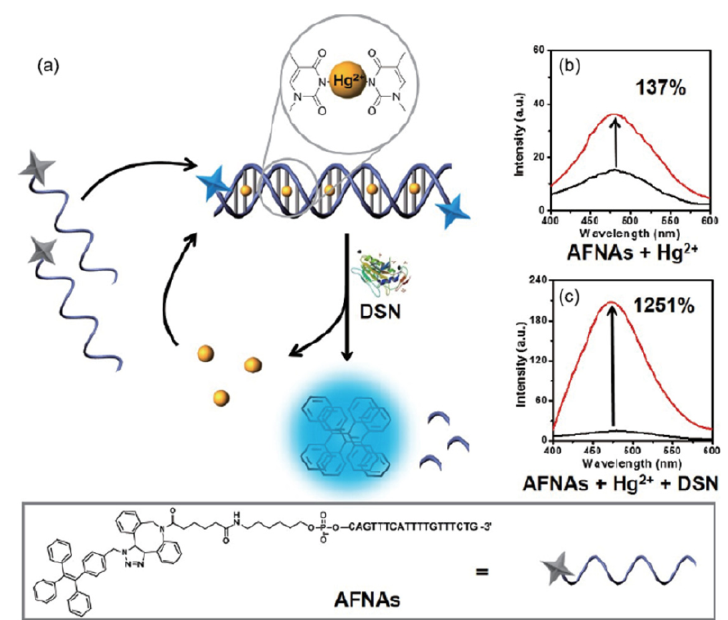
Figure 6. A scheme of a highly sensitive fluorescence biosensor to test Hg 2+ based on DSN and AIE. Reprinted with permission from [69]. Copyright 2017 Springer